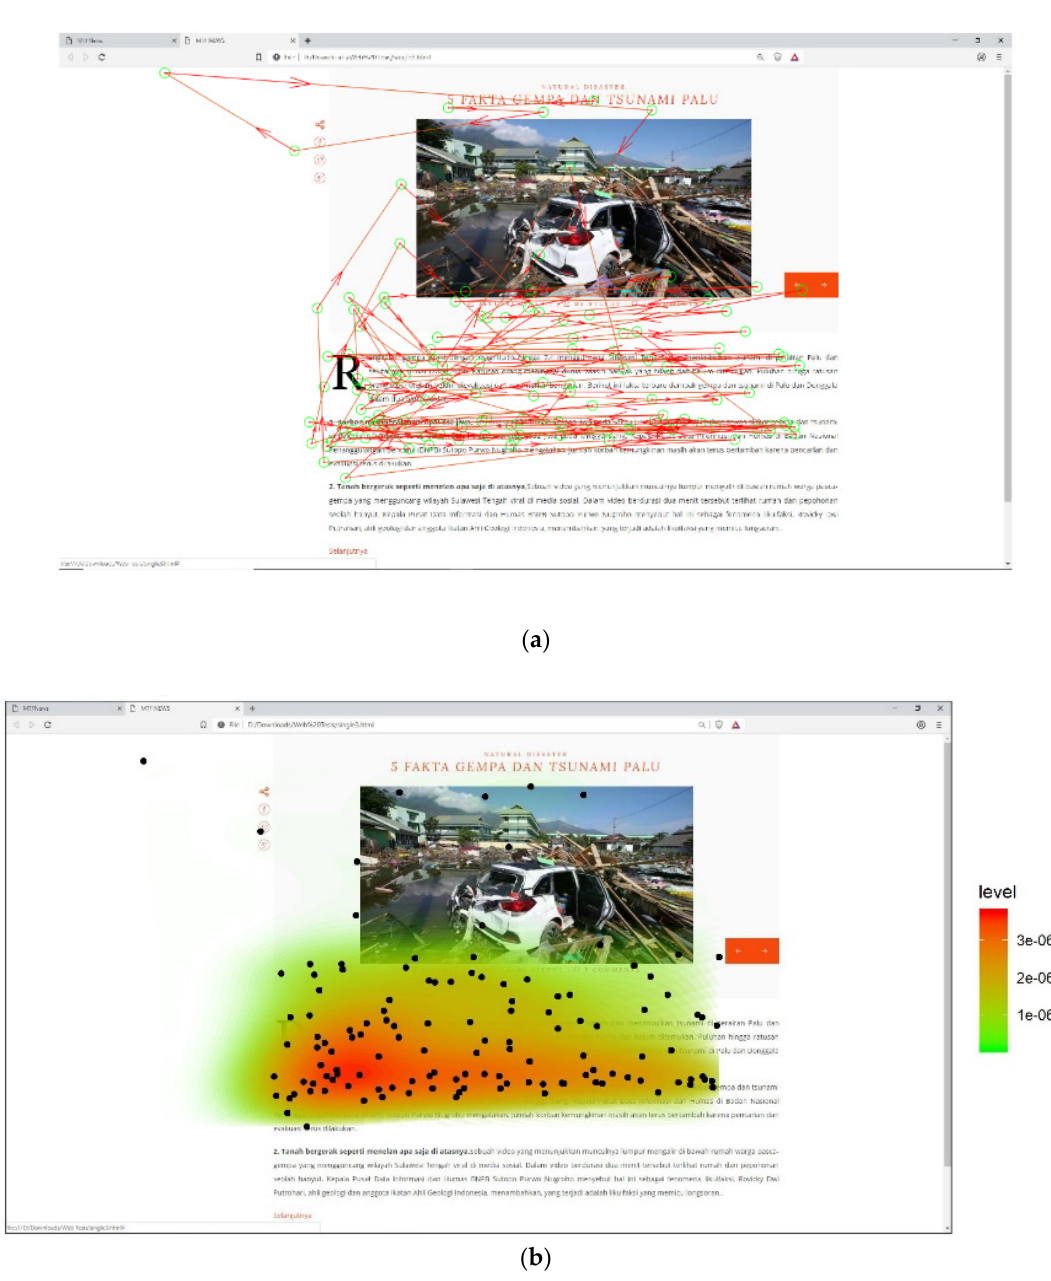
Figure 6. (a). Example of gaze plot of high anxiety; (b) example of heat map of high anxiety. Figure 6. ( a ) Example of gaze plot of high anxiety; ( b ) example of heat map of high